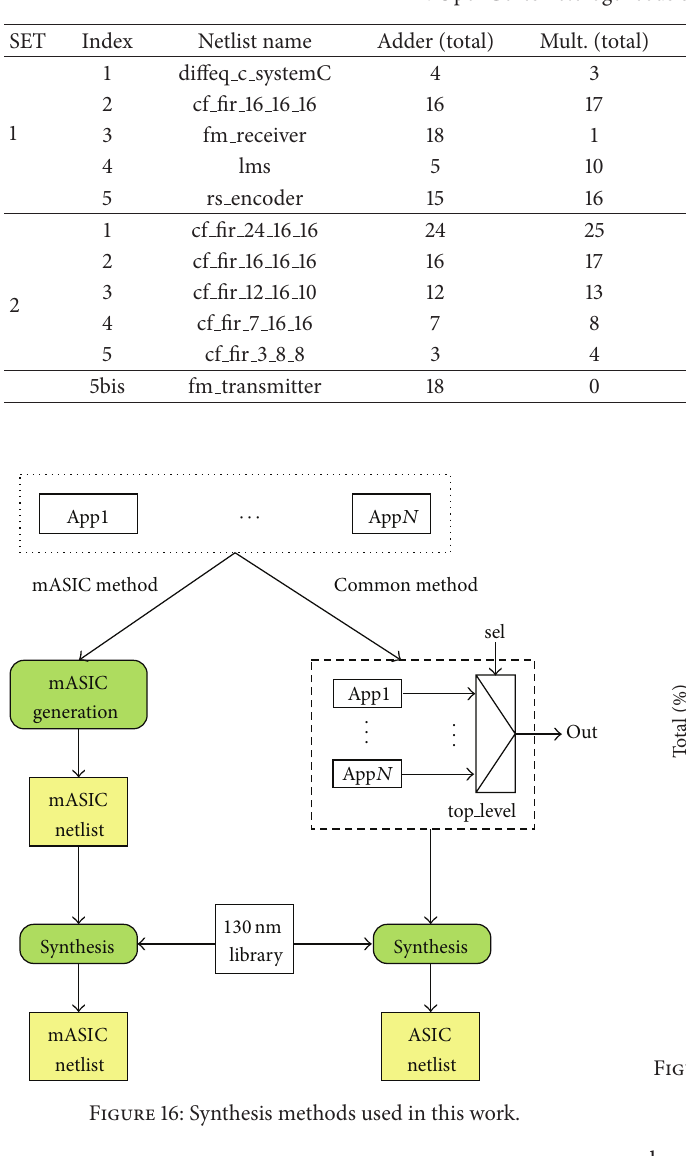
Table 2: OpenCores heterogeneous benchmark circuits [20].